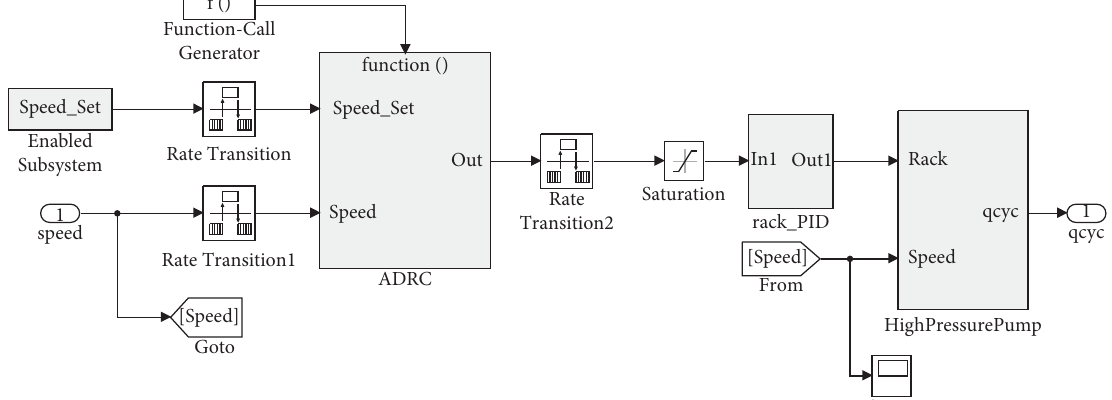
Figure 12: ADRC model for the engine speed control system.